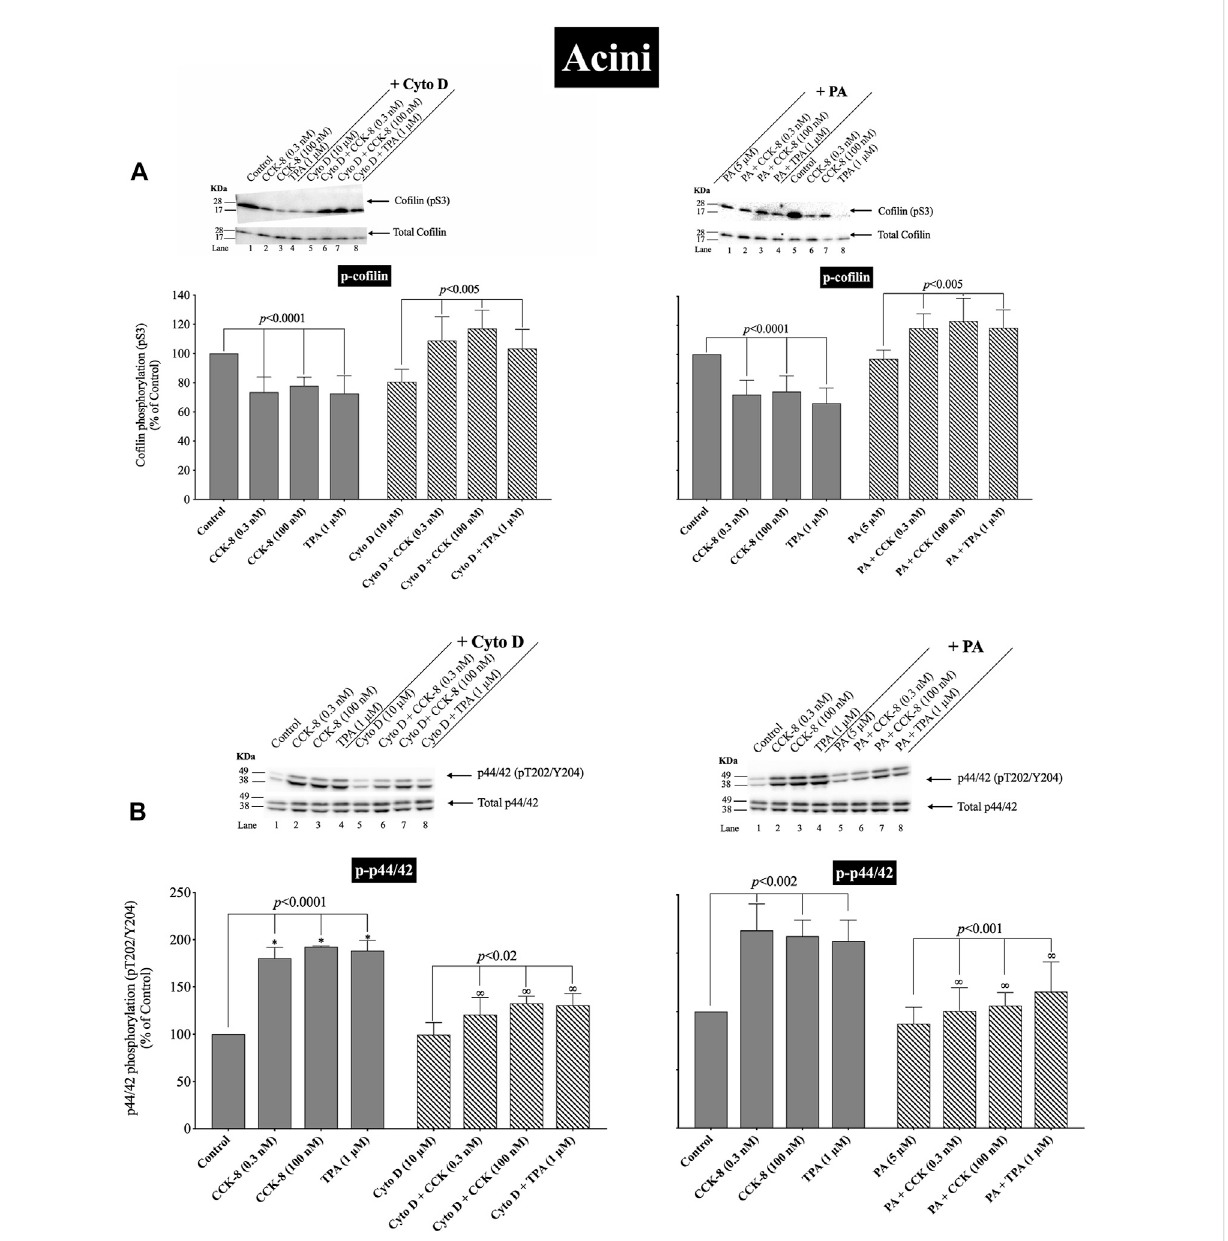
FIGURE 11 Effect of two co fi lin inhibitors, Cytochalasin D or Paclitaxel ( on the ability of CCK-8 (0.3 and 100 nM) and TPA (1 µM) to alter activation of co fi lin (A) and p44/42 (B) . Isolated pancreatic acini were incubated in the absence or presence of Cytochalasin D (10 µM) or Paclitaxel (5 µM) for 3 h and then incubated with no additions (control), CCK-8 (0.3and 100 nM) for 3 min or TPA (1 µM) for 5 min, and then lysed. Western blots wereanalyzed using anti- pS3 co fi lin, anti-pT202/Y204 p44/42 and Tubulin. Bands were visualized using chemiluminescence and quanti fi ed by densitometry. Top : Results of arepresentativeblotoffourindependentexperimentsareshown. Bottom :Means±S.E.ofatleast4independentexperiments.Resultsareexpressedas% of basal stimulation of the control group. *, p < 0.05 compared to the control group; ∞ , p < 0.05 compared to stimulants without